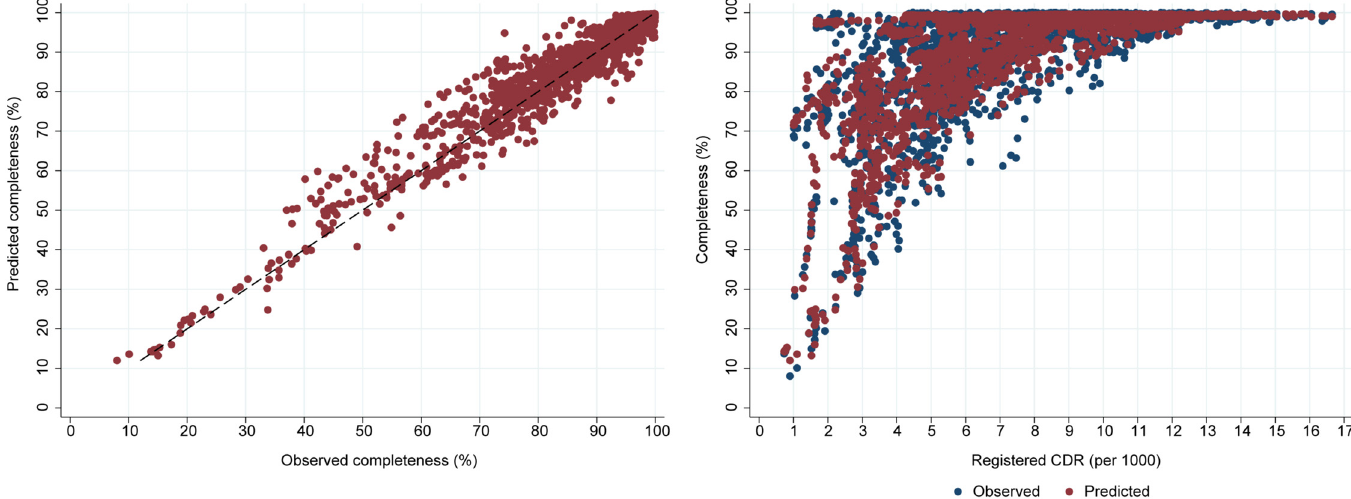
Fig 4. Predicted versus observed death registration completeness, and predicted versus observed death registration completeness by registered CDR, Model 2, both sexes.